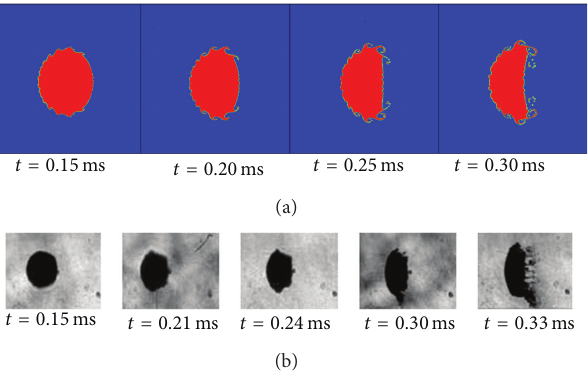
Figure 12: Evolution of a simulated droplet (a) and experimental observation of Boiko (b).